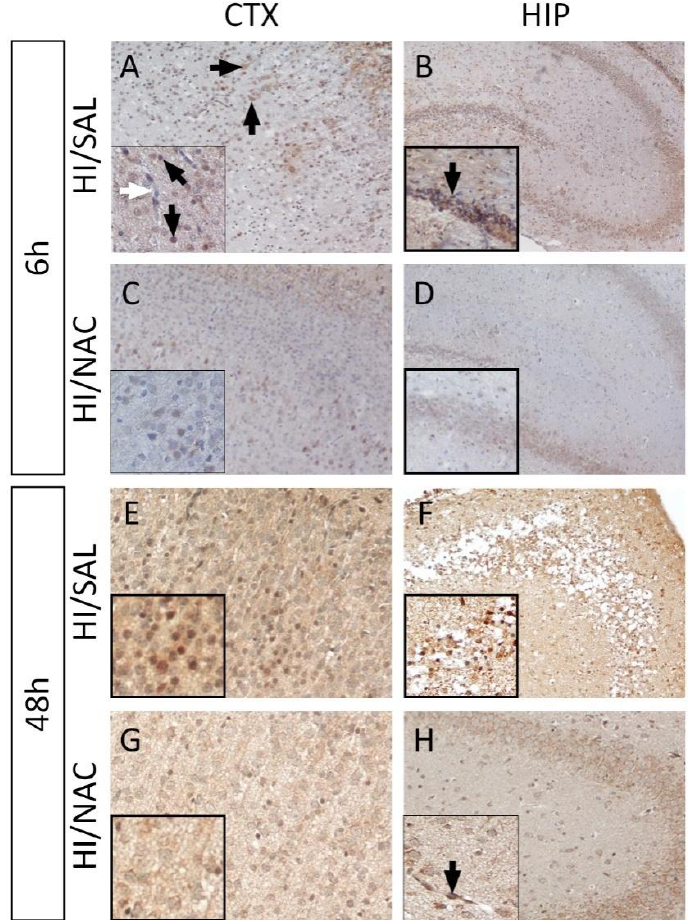
Figure 5. NAC administration reduces iNOS expression in NAC/HI group. Representative immuno- histochemical staining for iNOS expression (DAB-brown staining) in the cortex-CTX ( A , C , E , G ) and hippocampus-HIP ( B , D , F , H ) from each group at 6 h and 48 h following neonatal HI. Lower levels of iNOS expression are detected both in CTX and HIP in NAC/HI group compared to the control (HI/SAL). Regions with extensive damage appeared to have diminished iNOS expression due to neuronal loss. Blackarrows indicate the positive cells and vessels and the white arrow denotes the absence of staining in bloodvessels (Magnification = ×